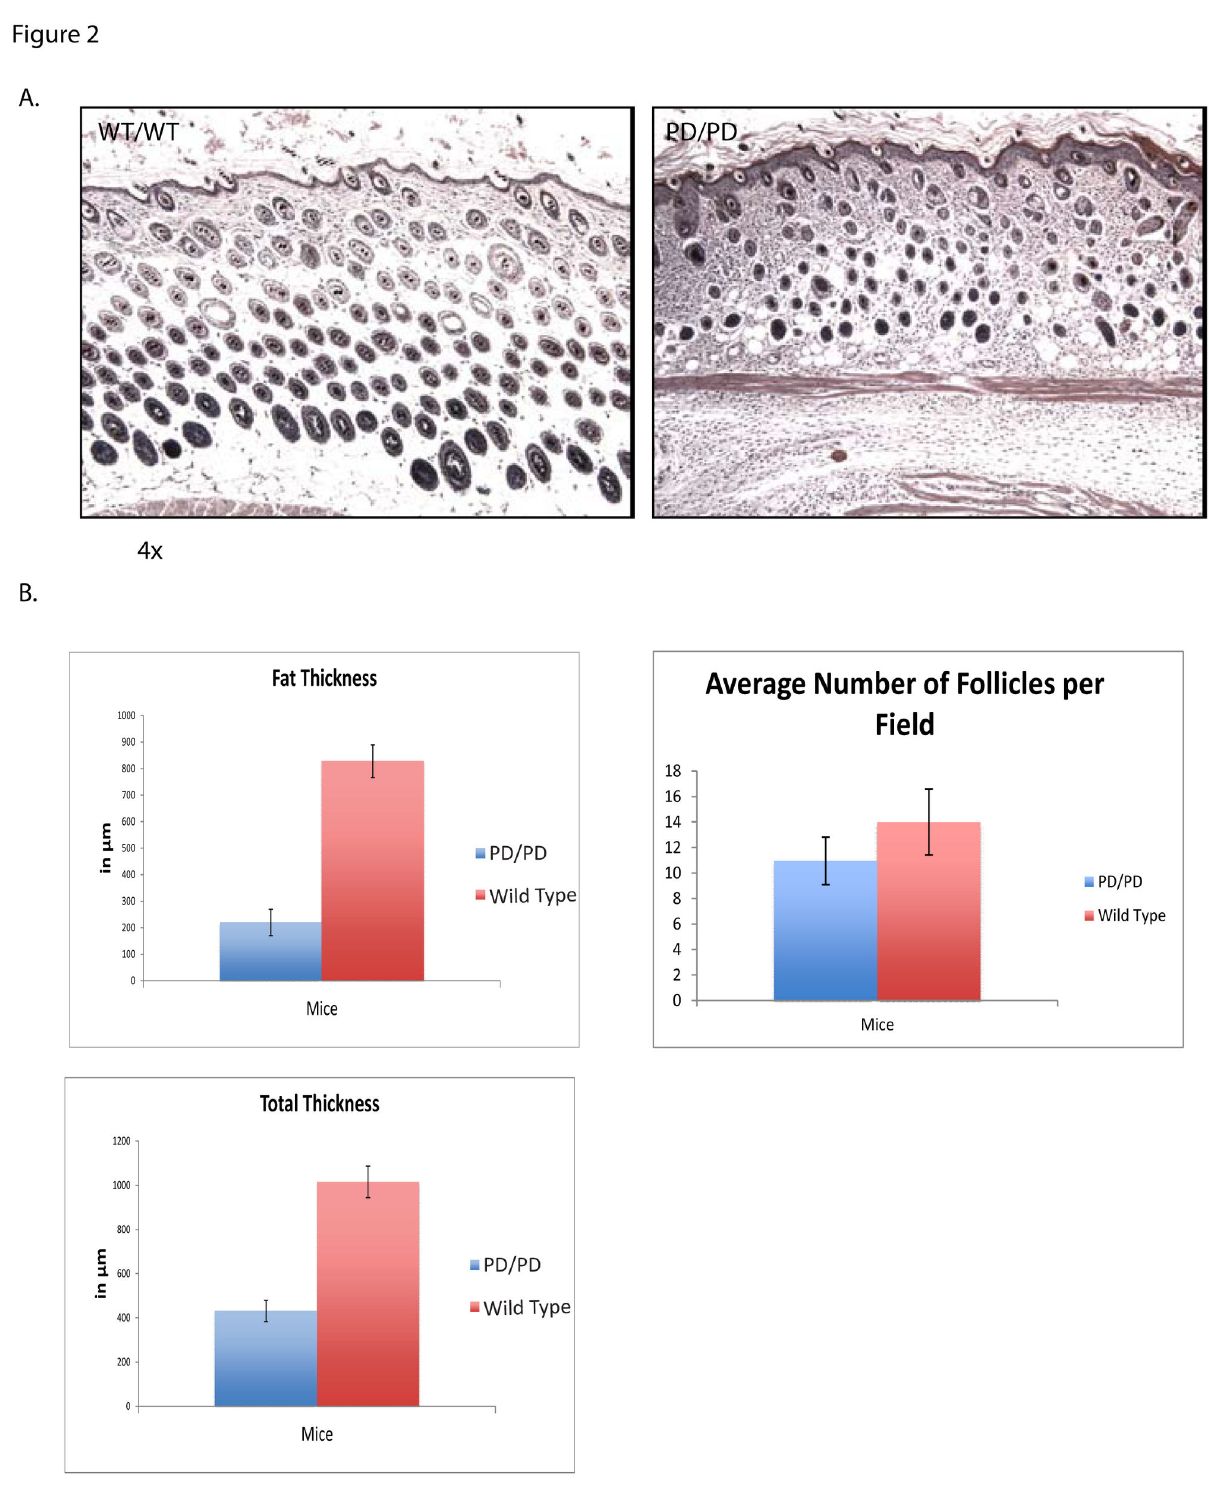
Figure 2. Histology of PD mouse skin. (H and E) A. The PD homozygous mouse skin at 10 days (right) has a thickened epidermis, a significant inflammatory infiltrate, decreased subcutaneous fat and fewer hair follicles compared to the wild-type littermates (left). B. The subcutaneous fat is decreased in the PD mouse skin and the total skin thickness is also diminished. The number of hair follicles is decreased. doi: 10.1371/journal.pone.0071887.g002 PLOS ONE |